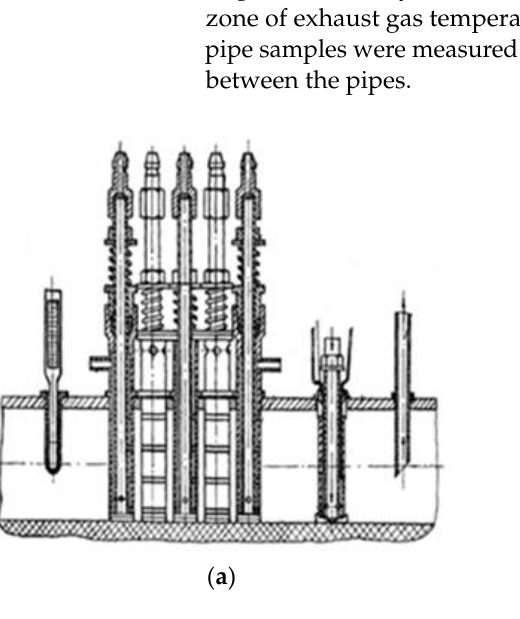
(weight m 3 ) (Figure 3).